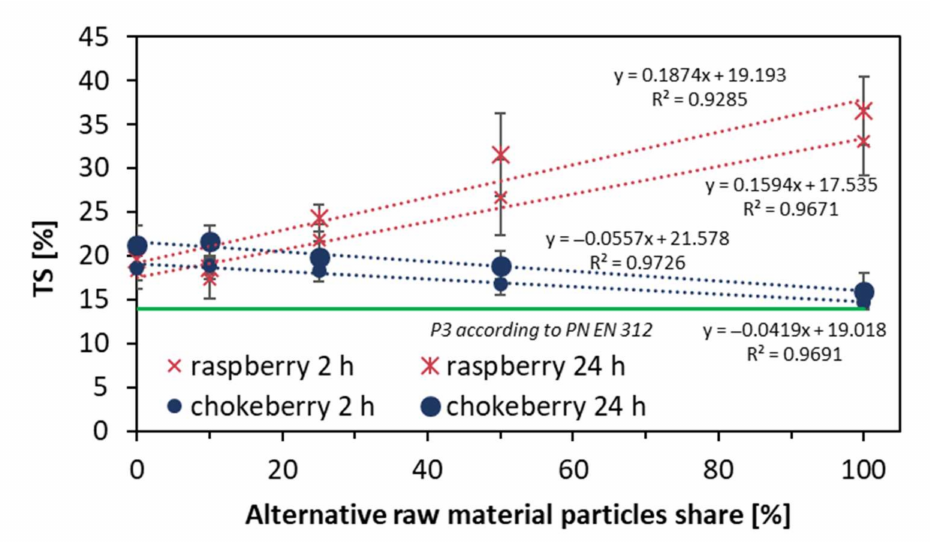
Figure 8. Thickness swelling of the tested